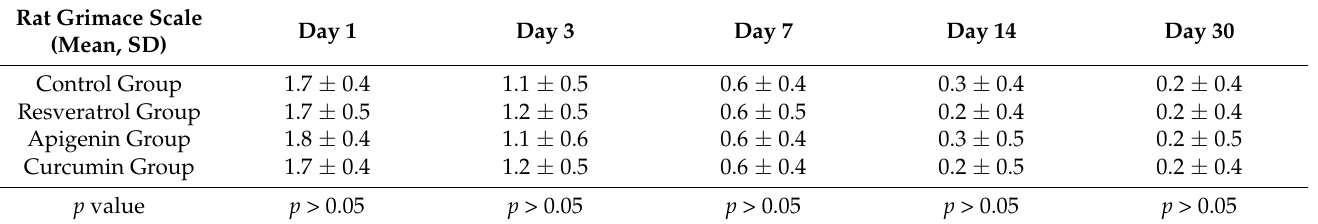
Table 1. Summary of the rat grimace scale at 1, 3, 7, 14. and 30 days for the control, apigenin, resveratrol, and curcumin groups.